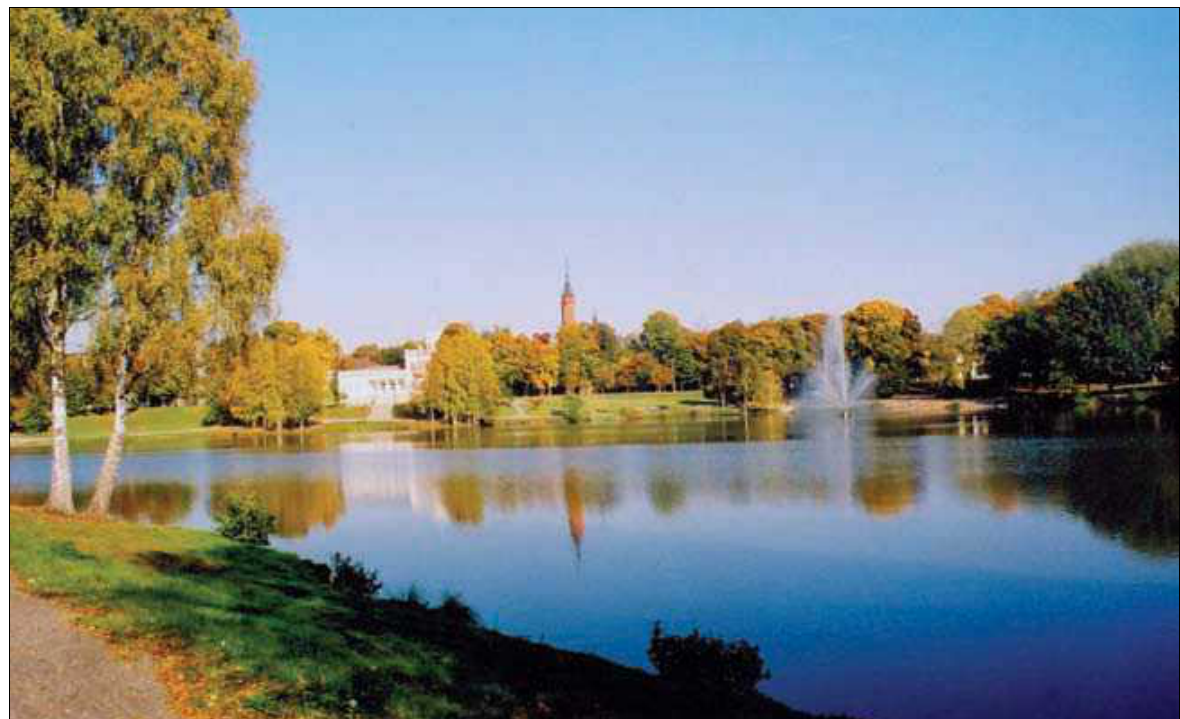
Fig. 7. Panorama of Druskininkai from the lake of Druskonis